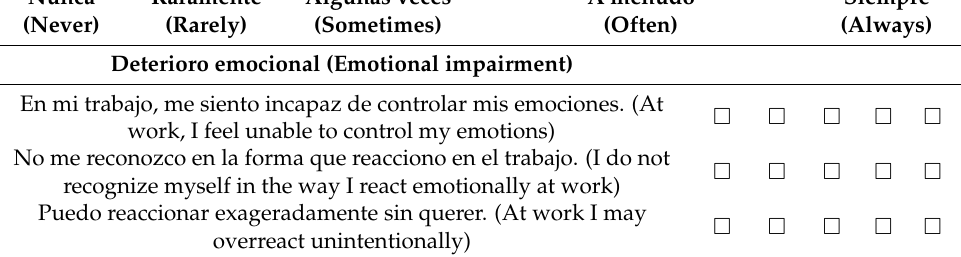
Table A2. Ecuadorian version of BAT-23. Nunca Raramente (Never) (Rarely)